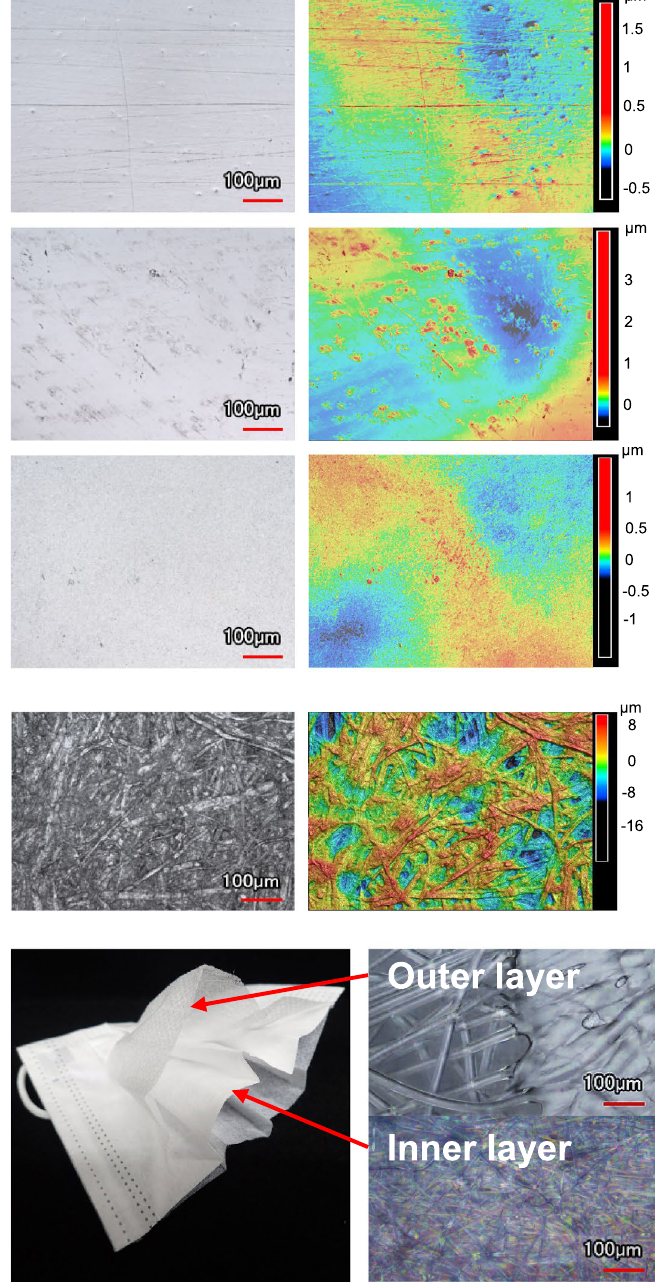
non-porous and porous substrates, respectively, investigated in this study. Panel ( c ), left: appearance and cross- sectional structure of the non-woven mask, right: microscopic observation of two layers of the non-woven mask. The 3D image of the non-woven mask could not be taken because its structure was too